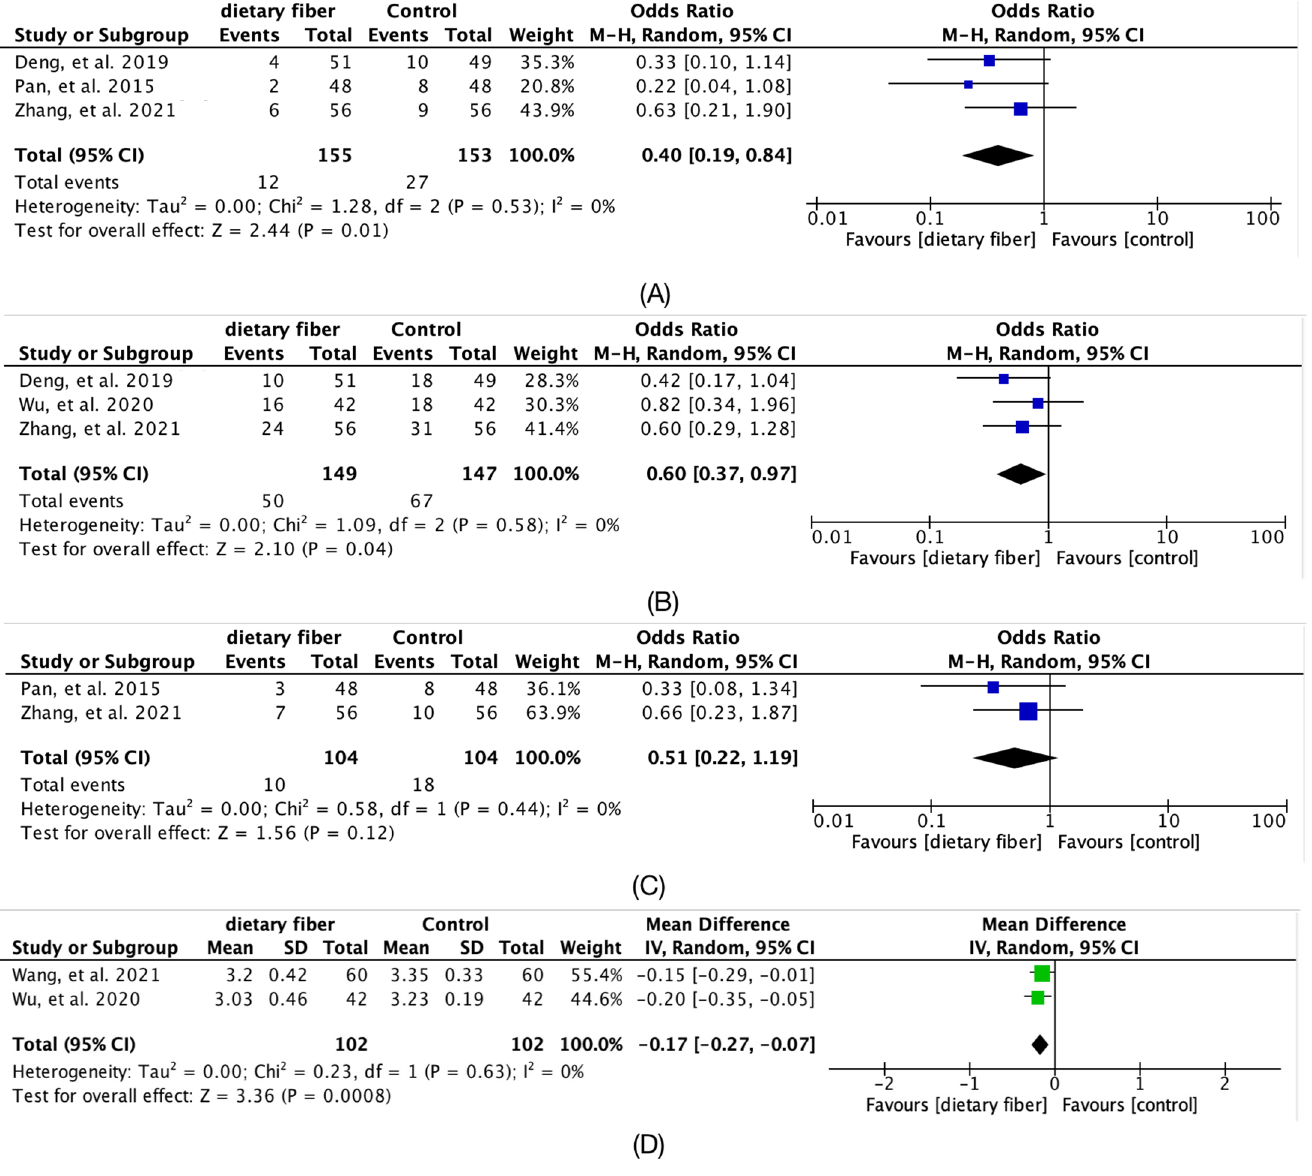
Figure 5. Forest plot for the overall meta-analysis of Pregnancy and neonatal outcomes: ( A ) preterm deliveries; ( B ) cesarean deliveries; ( C ) fetal distress; ( D ) neonatal weight.[15–17,21]